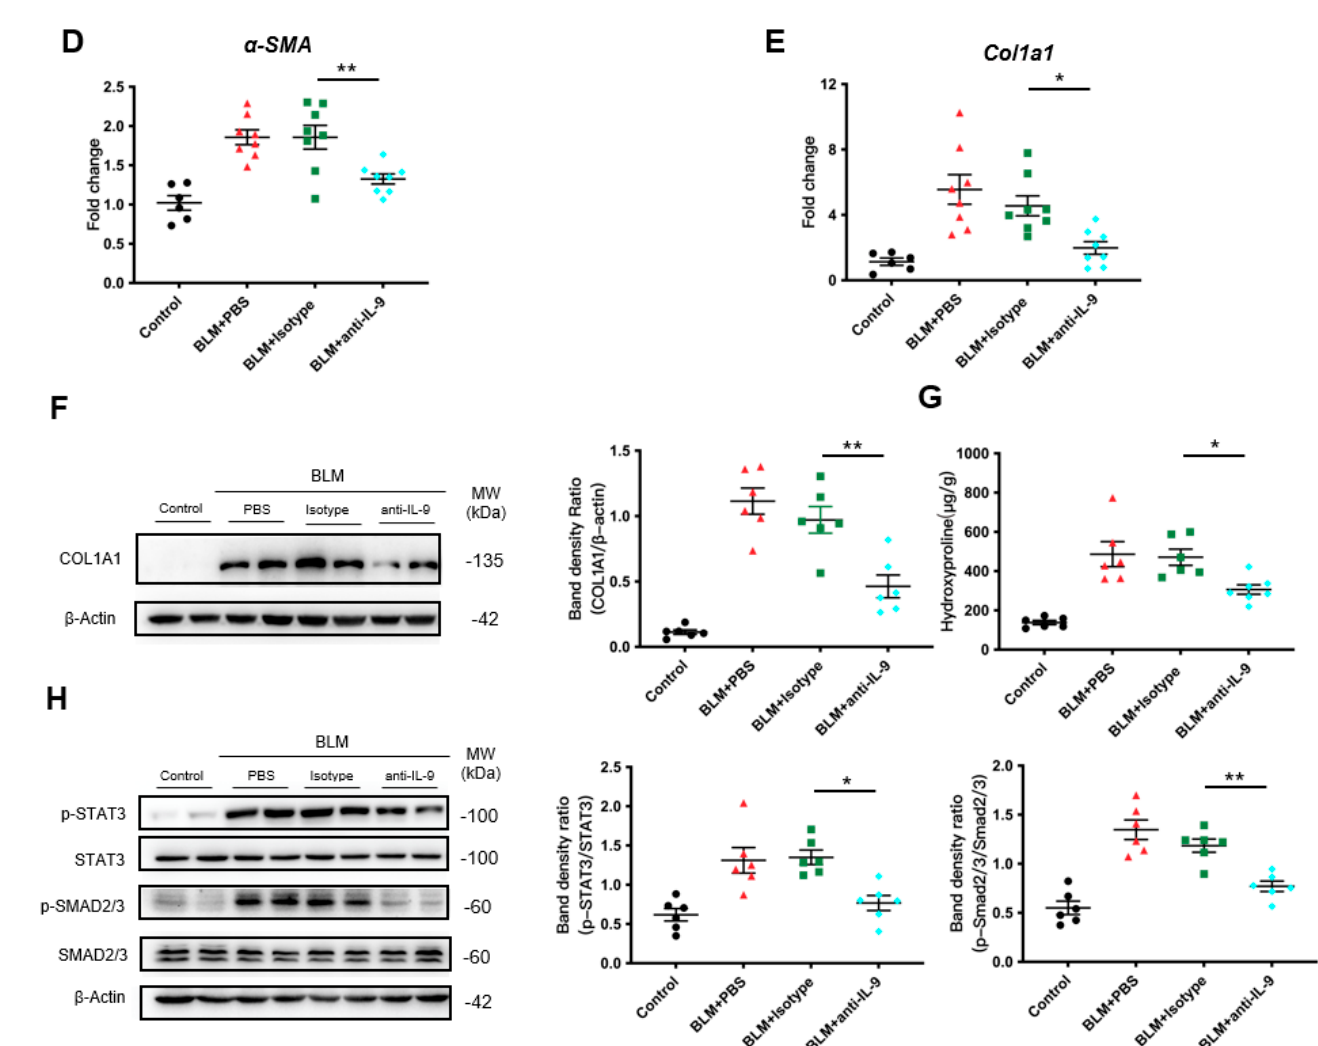
Figure 5. Neutralizing IL-9 attenuates pulmonary fibrosis and collagen content in the bleomycin (BLM)-induced pulmonary fibrosis mice (preventive intervention). ( A ) Schematic showing therapeutic intervention in the BLM model. Drugs (PBS/Isotype/anti-IL-9, every 3 days) were injected intraperitoneally starting at day 1, and lungs were assessed on day 21 after BLM administration. ( B ) Representative HE staining and quantitative analysis of lung sections from mice of different experimental groups (n = 6 to 12). Inflammatory cell infiltration was indicated by black arrows. Scale bars, 50 μ m. ( C ) Representative Masson’s trichrome staining and quantitative analysis of lung sections from mice of different experimental groups (n = 6 to 12). Deposited collagen was indicated by black arrows. Scale bars, 50 μ m. ( D – E ) Quantitative PCR analysis of α -SMA ( D ), Col1a1 ( E ) (n = 6 to 8) in mice of different experimental groups. ( F ) Representative Western blot images and quantitative analysis of COL1A1 in lung homogenates from mice of different experimental groups (n = 6). β -Actin was used as a loading control. ( G ) Lung hydroxyproline content in mice of different experimental groups (n = 6 to 7). ( H ) Representative Western blot images and quantitative analysis of STAT3 and SMAD2/3 phosphorylation and total expression of STAT3 and SMAD2/3 in lung homogenates from mice of different experimental groups. ( C – H ) p values were determined by one-way ANOVA. Data were expressed as mean ± SEM. * p < 0.05; ** p < 0.01.